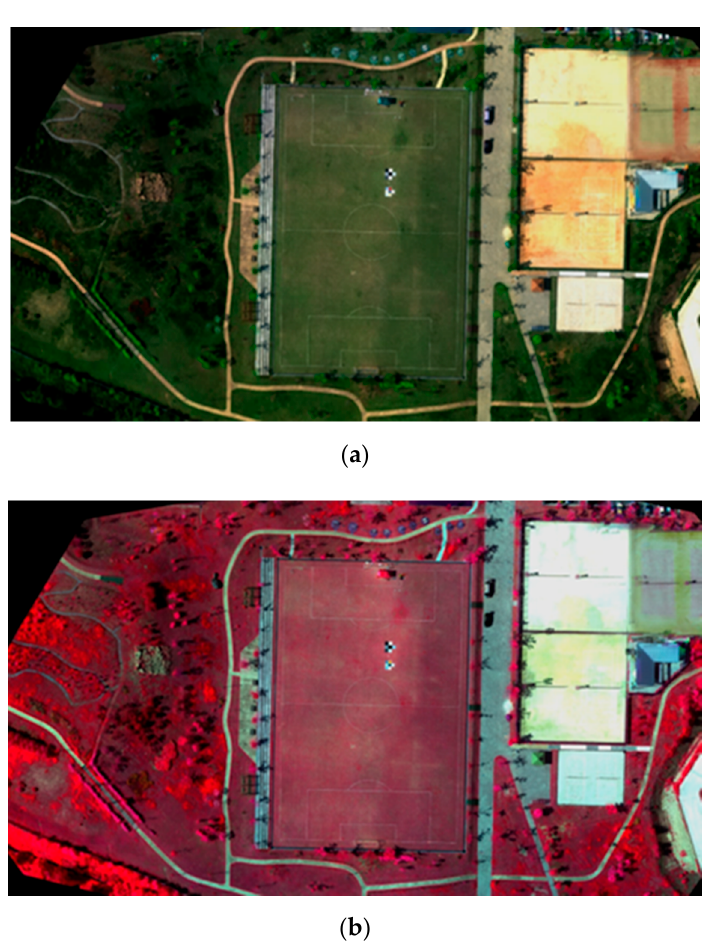
Figure 4. The reflectance map generated for validation: ( a ) a natural color composite and ( b ) a pseudo-infrared color composite.